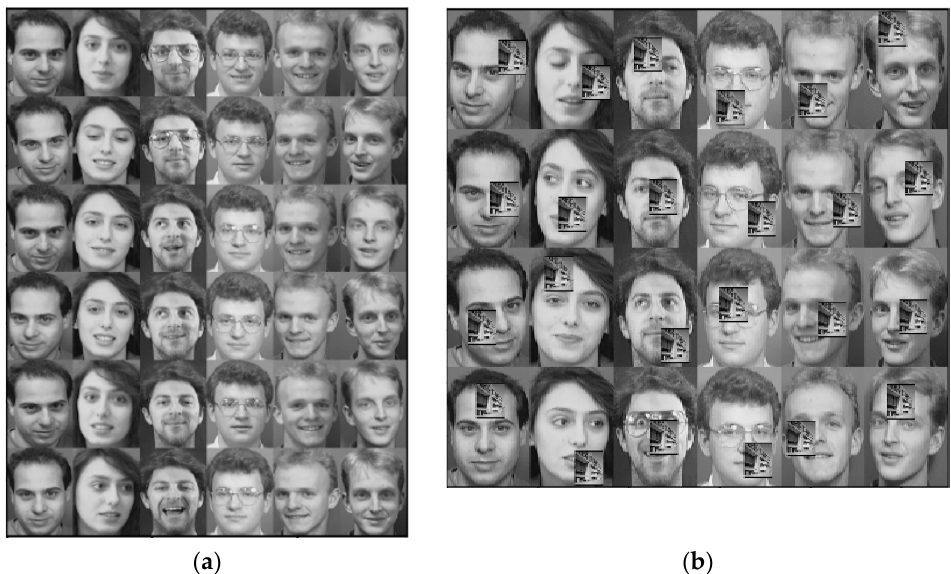
Figure 15. Some images from the ORL database: ( a ) the ORL database without occluded images; ( b )